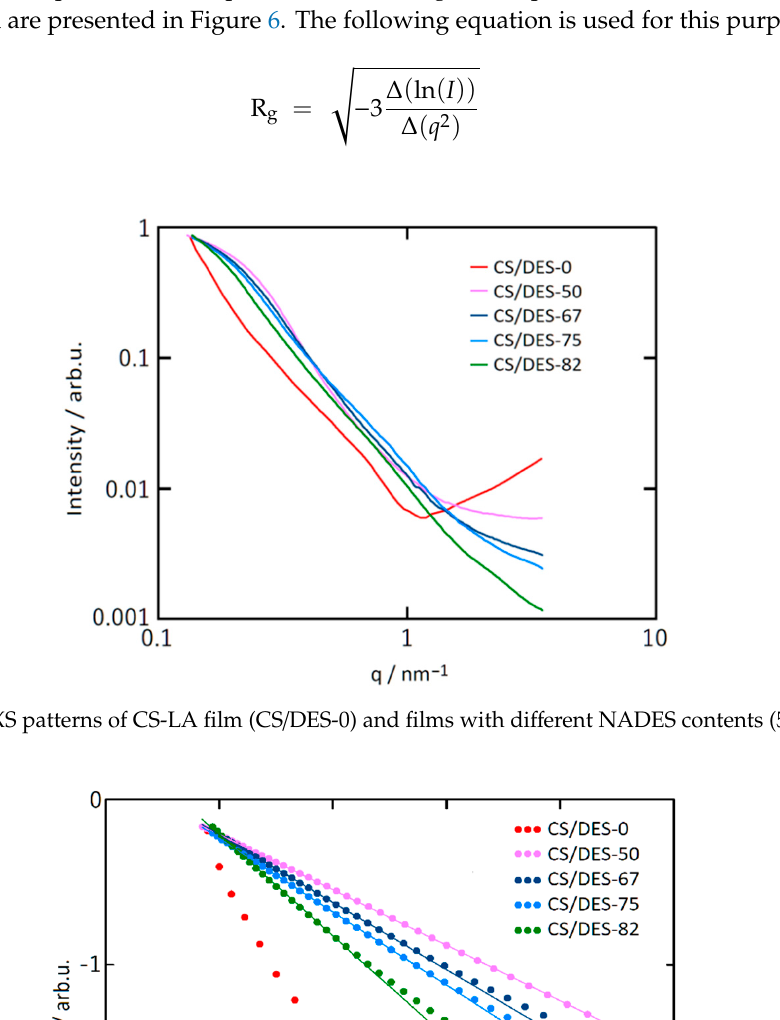
Table 1. The size of inhomogeneities (R g ) estimated from the slope of the initial portion of scattering curves plotted in Guinier coordinates.